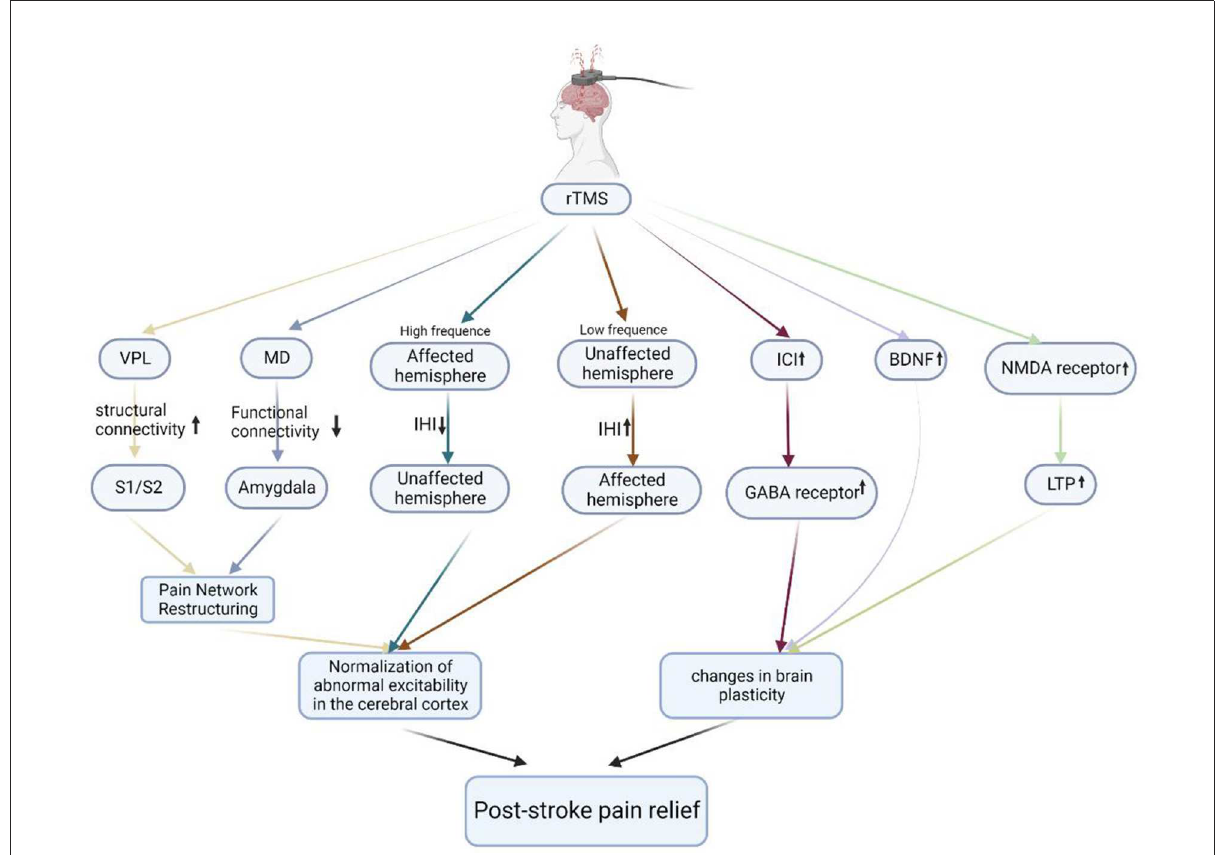
FIGURE1 The mechanisms of rTMS in the treatment of PSP. Schematic illustration of the underlying mechanism of rTMS in the treatment of PSP. rTMS modulates the abnormal excitability of the cerebral cortex by modulating the pain network, improving interhemispheric inhibition, and increasing the number of GABA receptors, BDNF expression, and the number of NMDA receptors to alter brain plasticity, ultimately relieving PSP. VPL, ventral posterolateral nucleus; S1, primary somatosensory cortex; S2, secondary somatosensory cortex; MD, mediodorsal nucleus; IHI, interhemispheric inhibition; ICI, intracortical inhibition; GABA receptor, gamma-aminobutyric acid receptor; BDNF, brain-derived neurotrophic factor; NMDA receptor, N-methyl-D-aspartate receptor; LTP, long-term